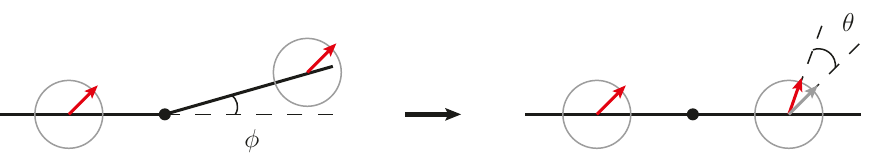
Figure 2 . For the 1/2-BPS cusp the small ’ limit at null internal angle (the red arrow in the cartoon stems for a direction in the internal space) is equivalent to the small (cid:18) limit at zero ’